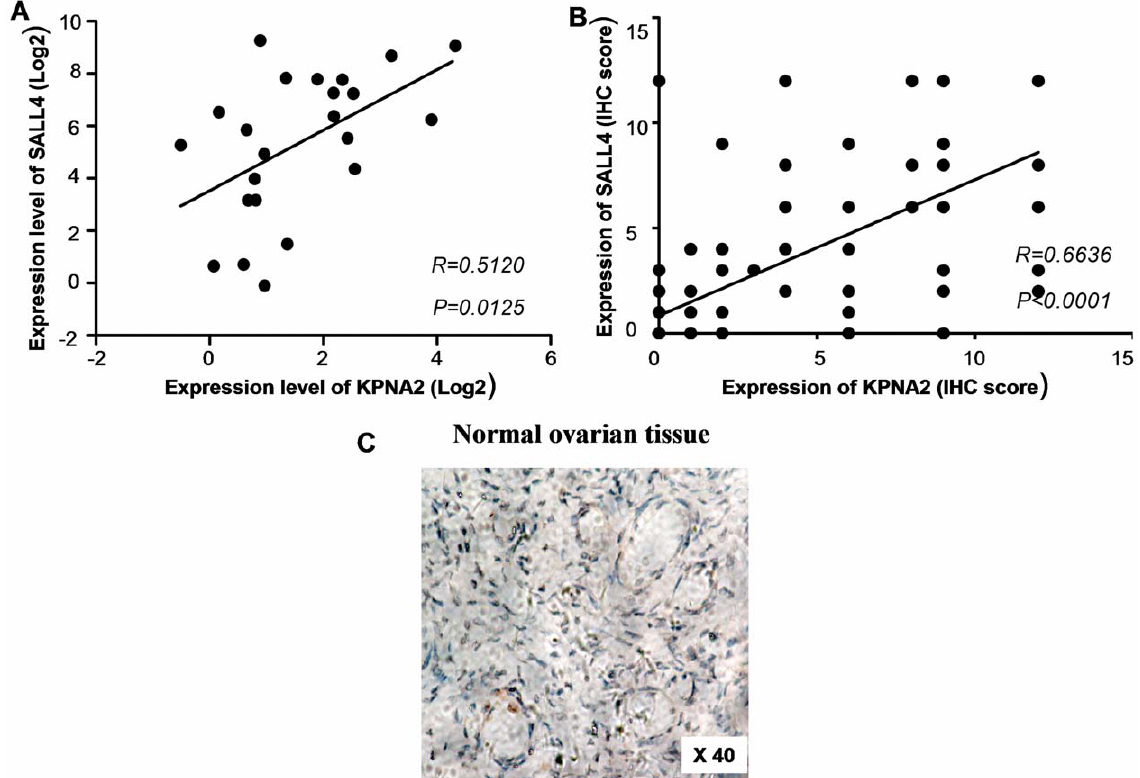
Figure 2. Correlation between KPNA2 expression and SALL4 expression. A. A positive correlation between KPNA2 and SALL4 expression was observed at the transcription level. B. A positive correlation between KPNA2 and SALL4 expression was observed at the translation level. C. Negative IHC staining was observed in normal ovarian tissue. (Ori. mag. 6 40).